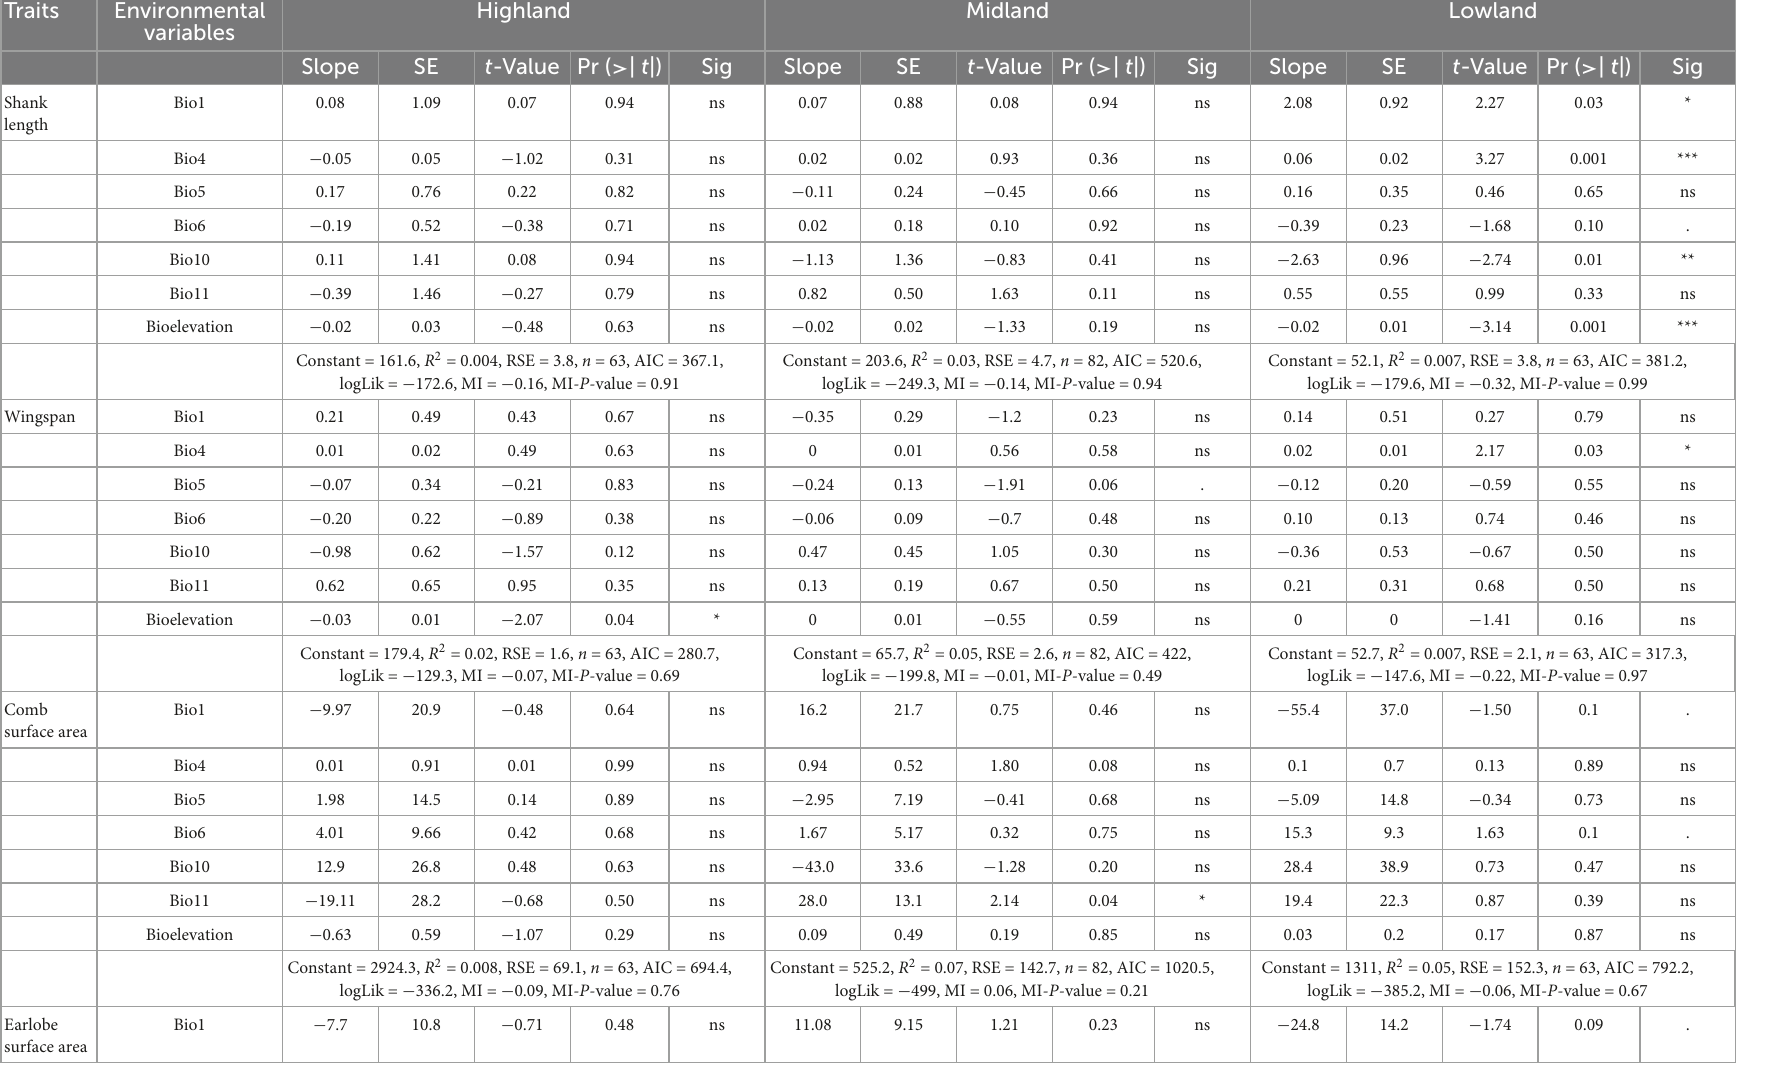
TABLE 5 Relationships (multiple linear regression) between female chicken appendages and environmental variables (Allen’s rule). Traits Environmental Highland Midland Lowland variables Slope Shank